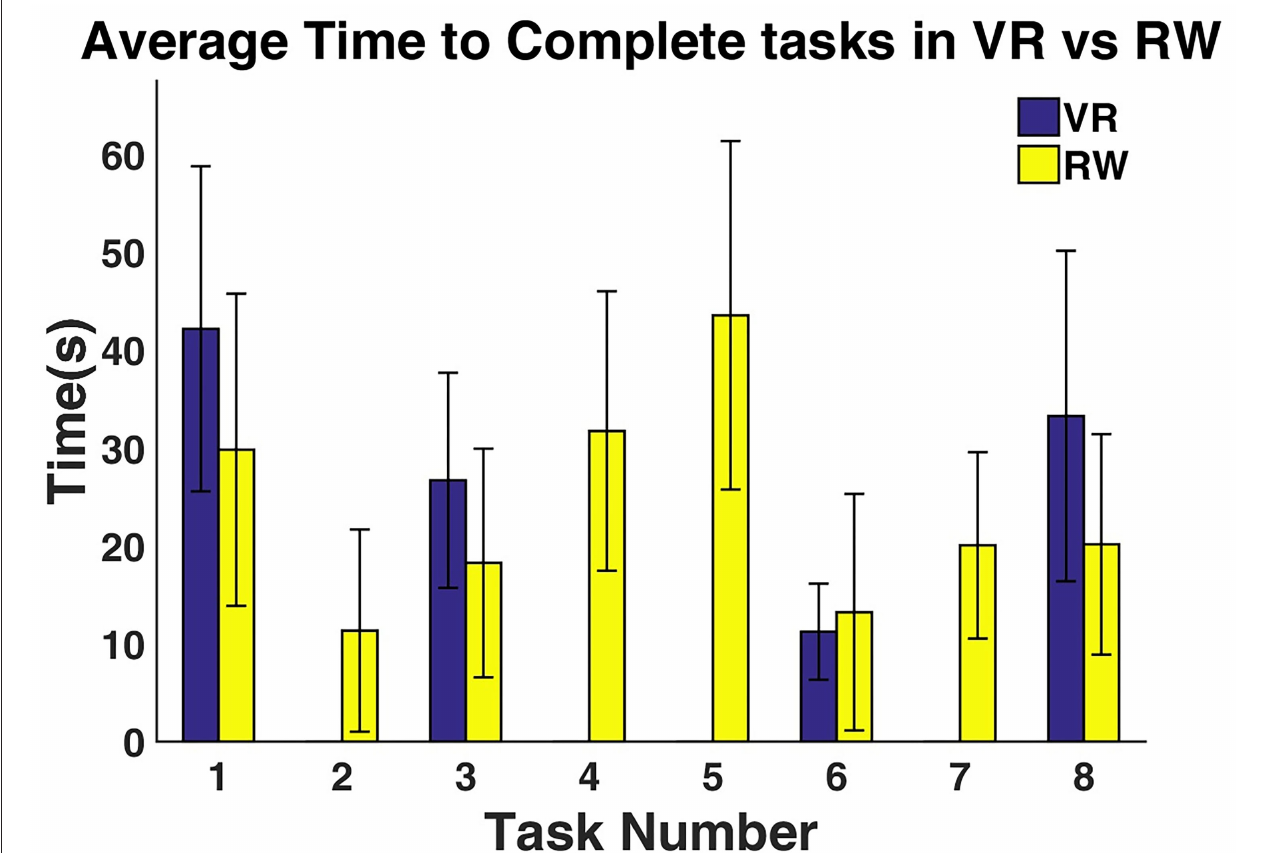
FIGURE 6 | Average time it took subjects to complete tasks in VR vs. RW. Tasks 2, 4, 5, and 7 do not have an average completion time in VR because they could not be completed. Task 6 was the only task that subjects were able to complete faster in VR than in RW. Error bars display standard deviation of the